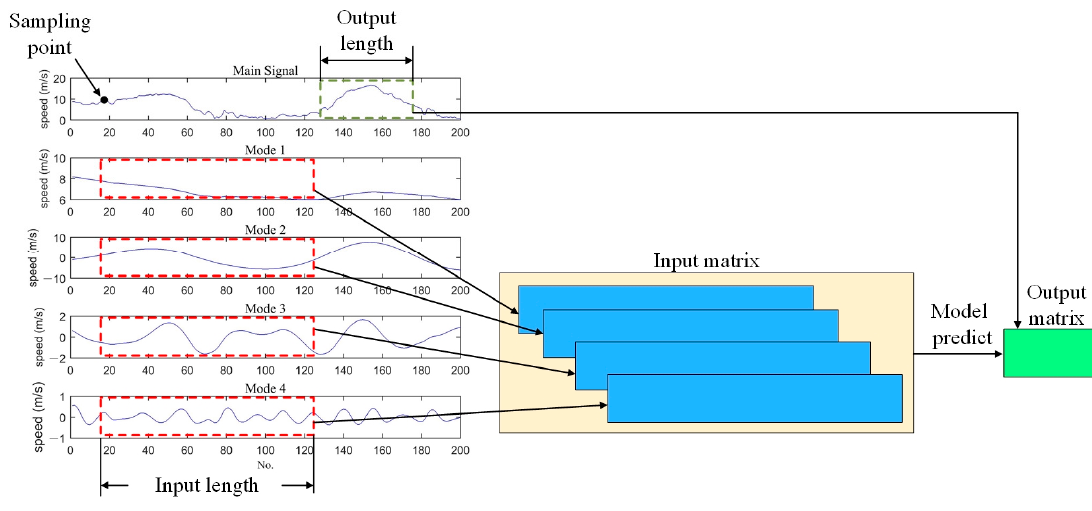
Figure 3. Constitution of input and output matrices.